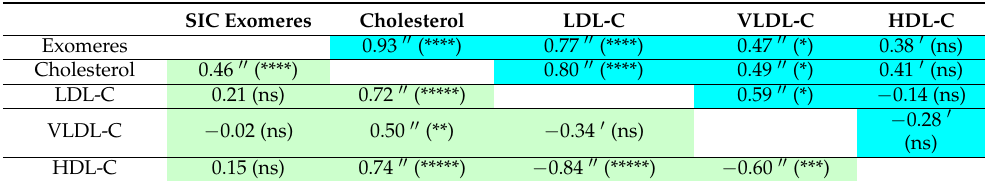
Table 1. Pearson correlation and partial correlation coefficients of lipid profile parameters and SIC exomeres and in the control